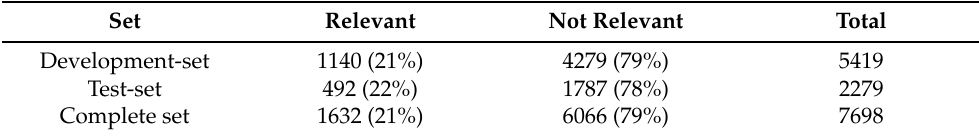
Table 3. Number of annotated tweets per